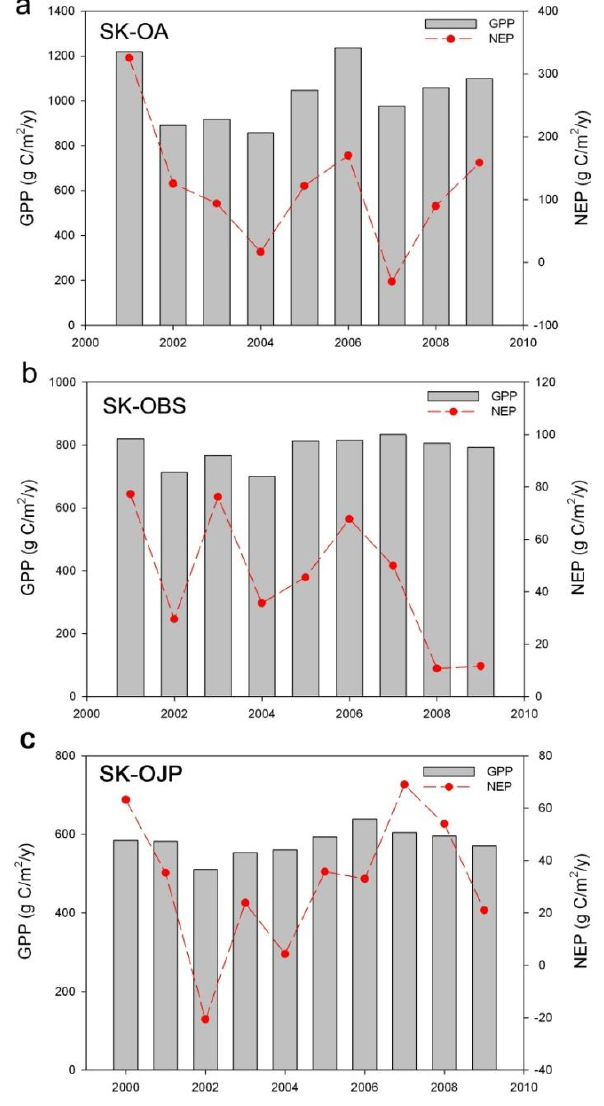
Figure 2. Annual patterns of ecosystem C fluxes at ( a ) SK-OA, ( b ) SK-OBS, and ( c ) SK-OJP; histogram and point represent gross primary production (GPP) and net ecosystem production (NEP),